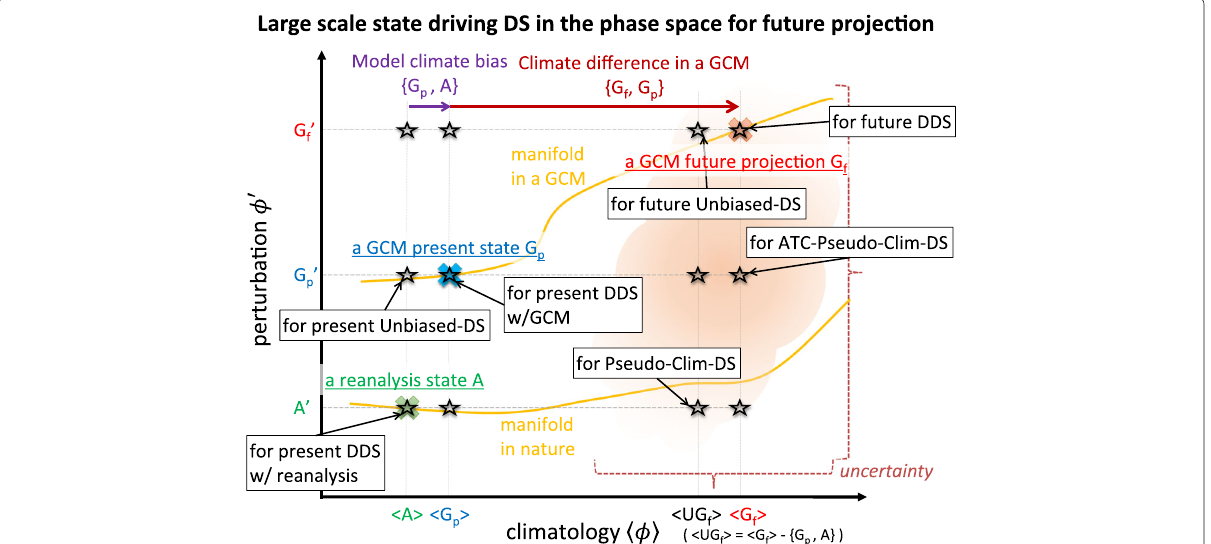
Fig. 2 Schematic diagram of the large-scale state driving the downscaling simulations. Cross marks show the states realized by reanalysis and GCM simulations. Stars represent the possible large-scale states driving the downscaling simulations. The orange shaded area represents the range of uncertainty in the estimation or existence probability distribution of the future state. The yellow line shows the manifold corresponding to the relationship between climatology and